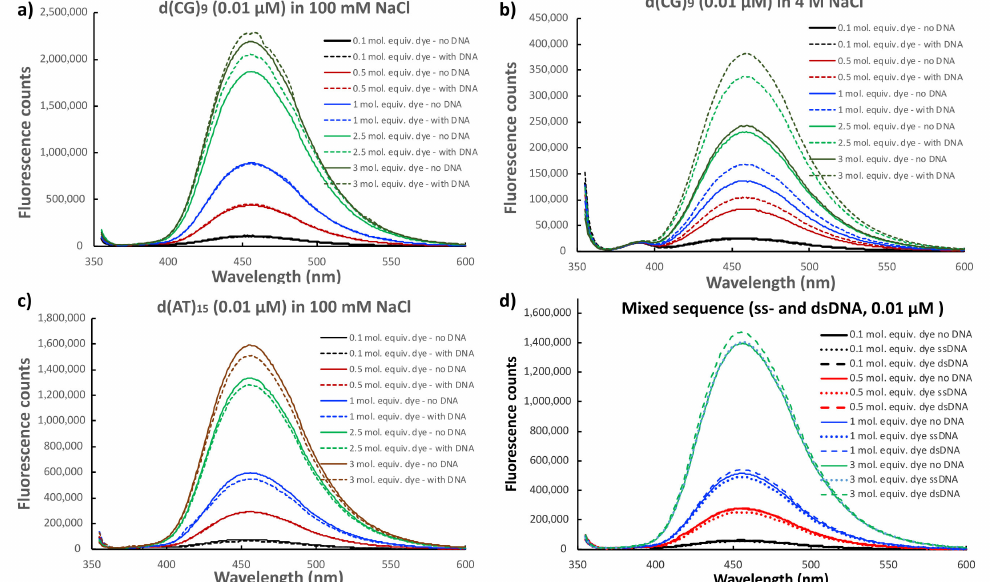
Figure 3. Fluorescence profiles of 4-phenyl-1,8-naphthalimide in the presence of DNA. ( a ). d(CG) 9 in 100 mM NaCl; ( b ). d(CG) 9 in 4 M NaCl; ( c ). d(AT) 15 in 100 mM NaCl; and ( d ). mixed sequence ss- and ds-21-mer,